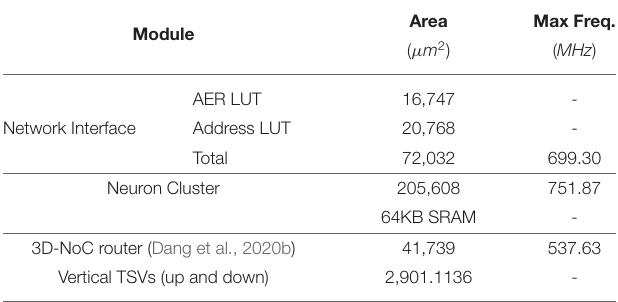
TABLE 2 | Hardware complexity of the proposed R-NASH node. Module